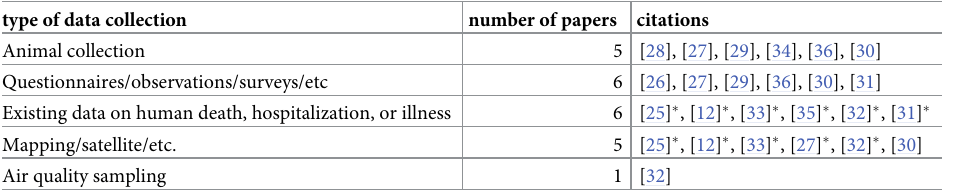
Table 4. Data collection sources/instruments used in selected